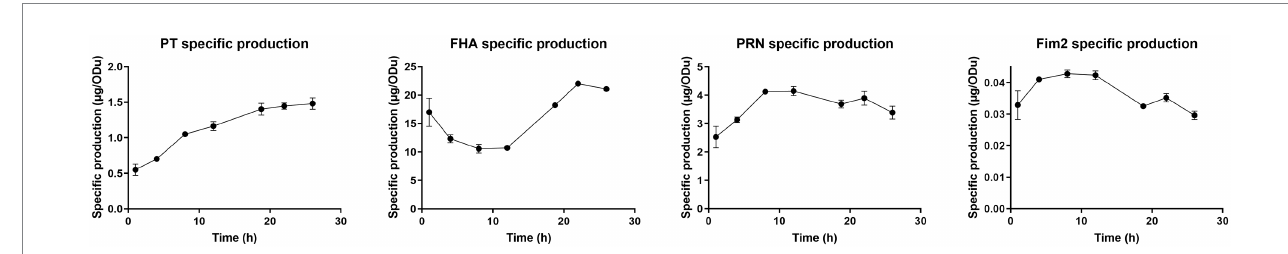
FIGURE 7 Specific antigen production throughout Bordetella pertussis culture. ELISA antigen quantification was performed for each antigen on lysed crude harvest and normalized using biomass measured with OD 650